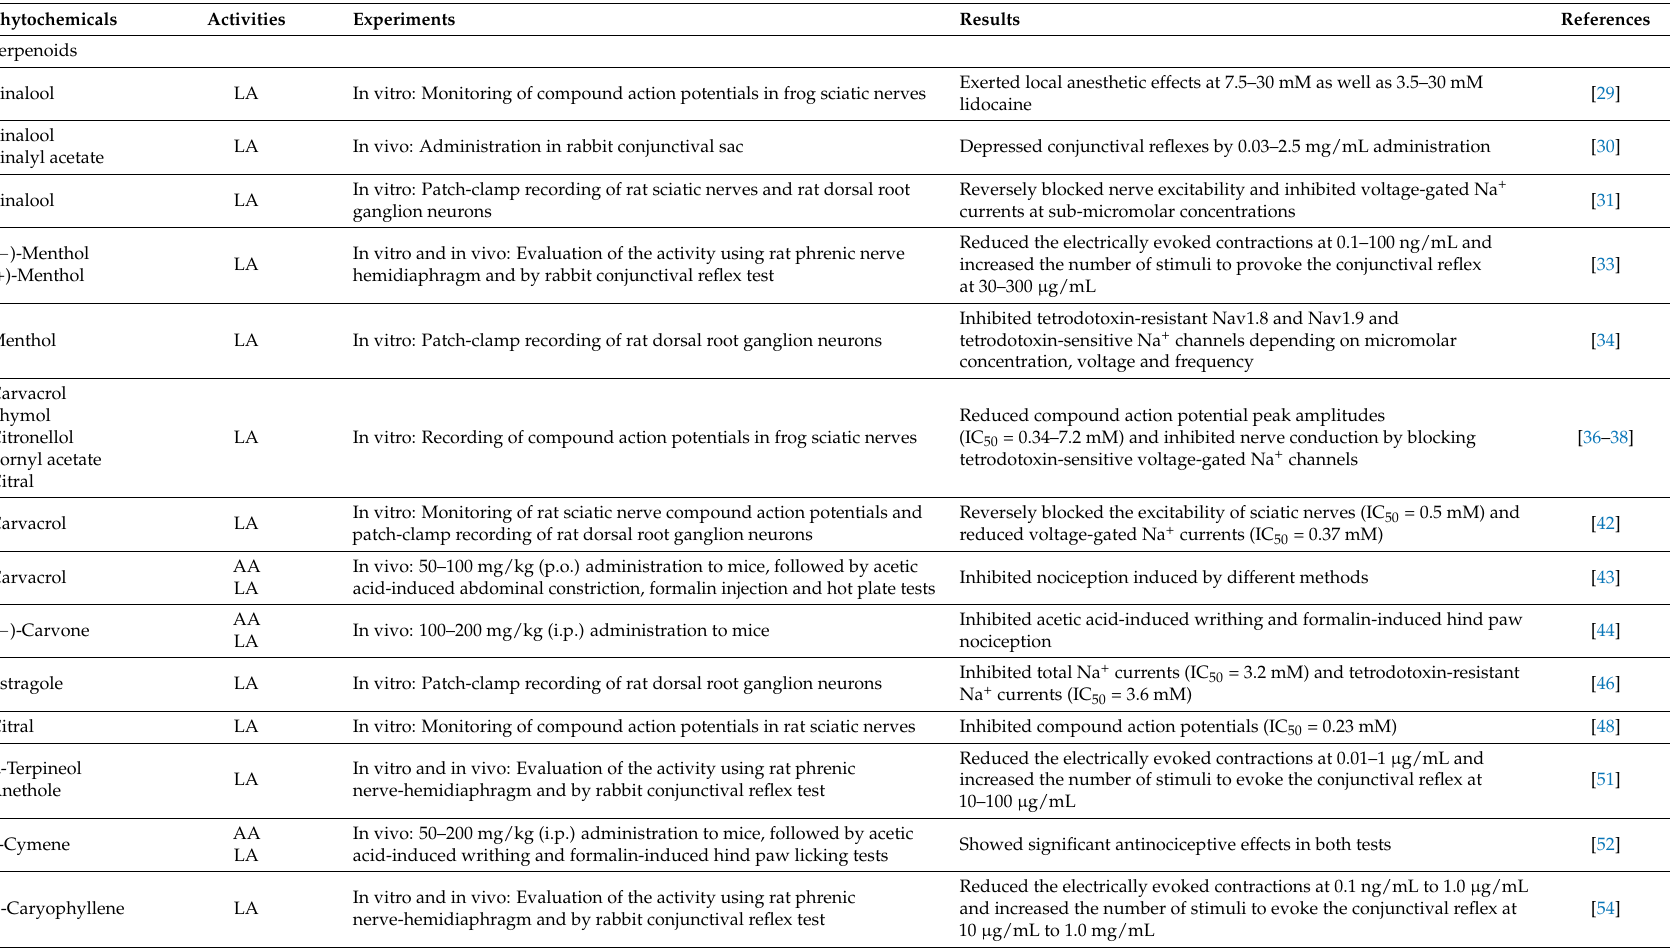
Table 1. Phytochemicals with anesthetic